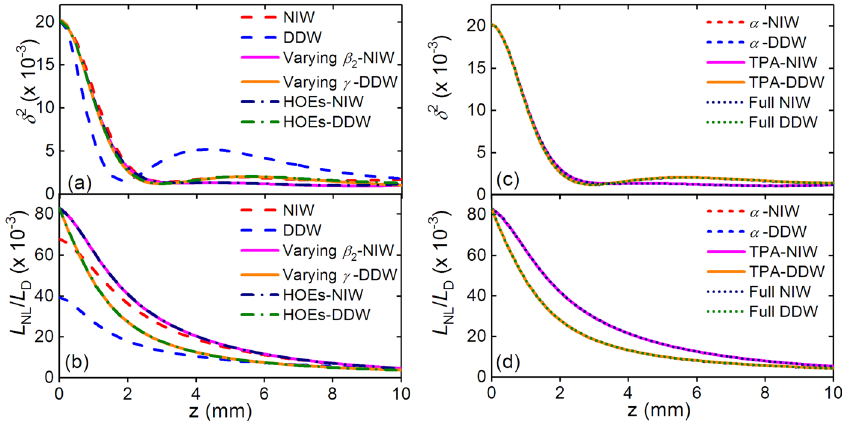
Figure 10. ( a ) The mismatch factor δ 2 and ( b ) ratio L NL / L D at 2150 nm for NIW (red dashed curves), DDW (blue dashed curves), varying β 2 -NIW (magenta solid curves), varying γ -DDW (orange solid curves), HOEs- NIW (navy dot-dashed curves) and HOEs-DDW (olive dot-dashed curves). ( c ) The mismatch factor δ 2 and ( d ) ratio L NL / L D at 2150 nm for α -NIW (blue dashed curves), α -DDW (red dashed curves), TPA-NIW (magenta solid curves), TPA-DDW (orange solid curves), Full NIW (navy dot-dashed curves), Full DDW (olive dot- dashed